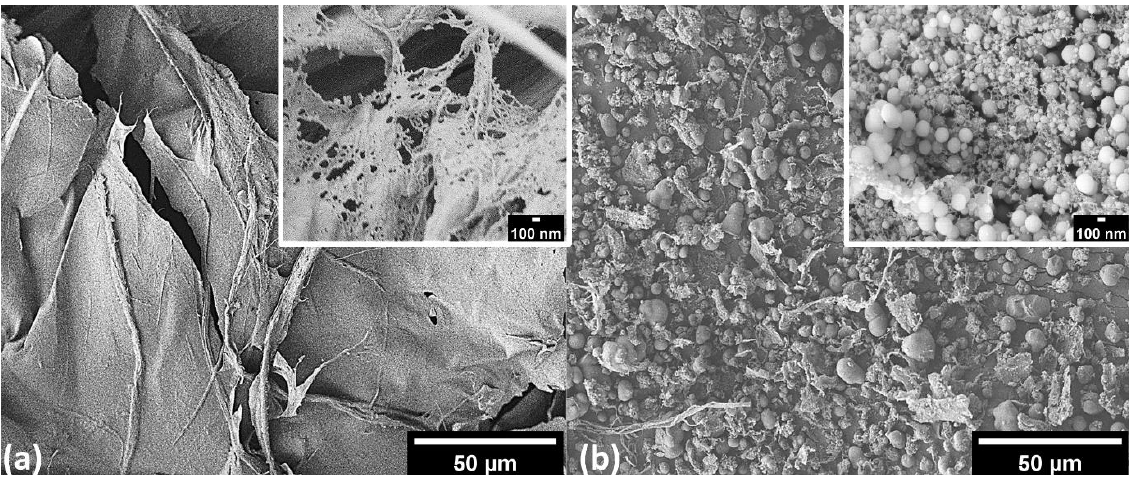
Figure 6. FE-SEM images of ( a ) FD-CNFs; ( b ) TMCNFs.